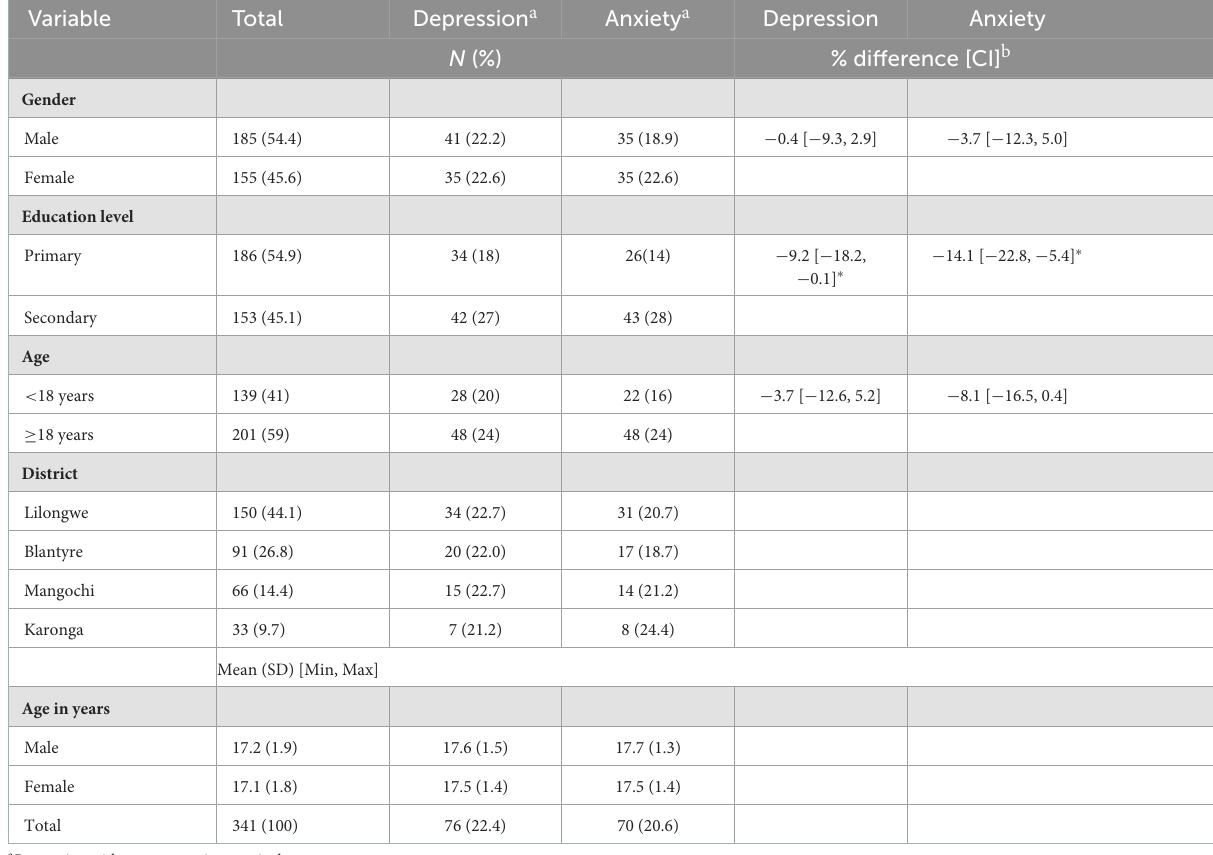
TABLE 1 Demographics, depression, and anxiety